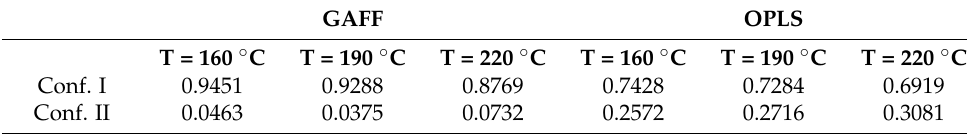
Table 5. Normalized MA conformer populations obtained using GAFF and OPLS force fields.